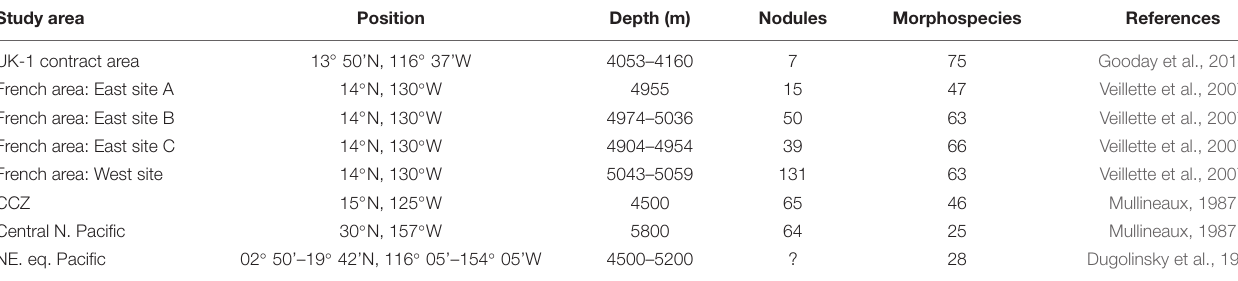
TABLE 3 | Number of foraminiferal morphospecies associated with nodules within, and to the north of the CCZ. Study area Position Depth